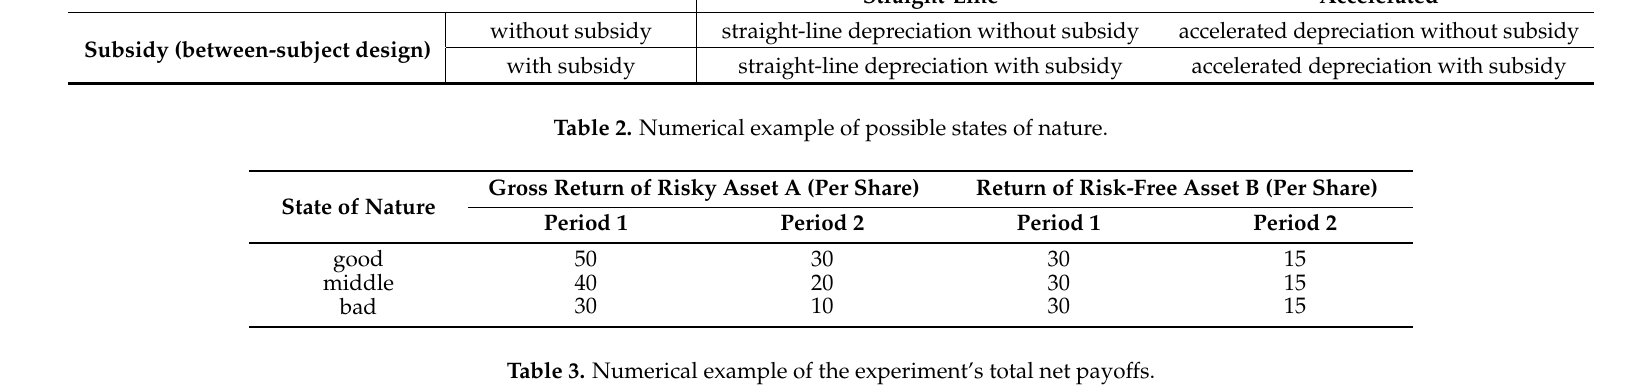
Table 3. Numerical example of the experiment’s total net